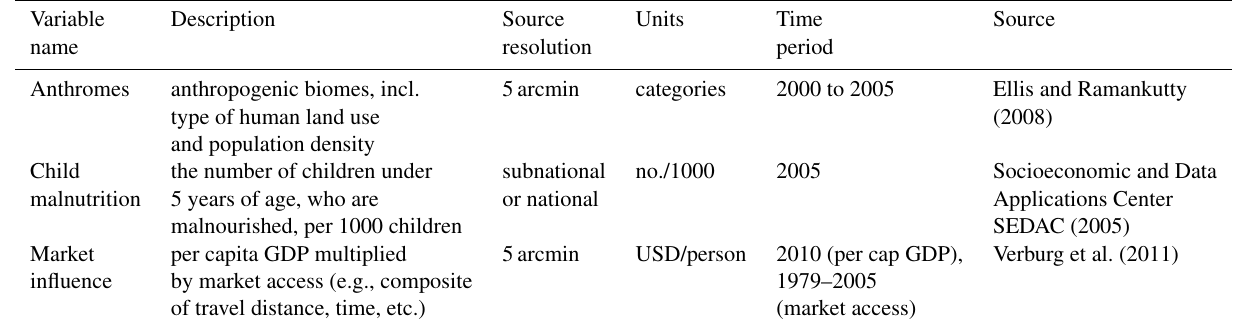
Table 2. Summary of metadata for anthromes, child malnutrition, and market influence data.